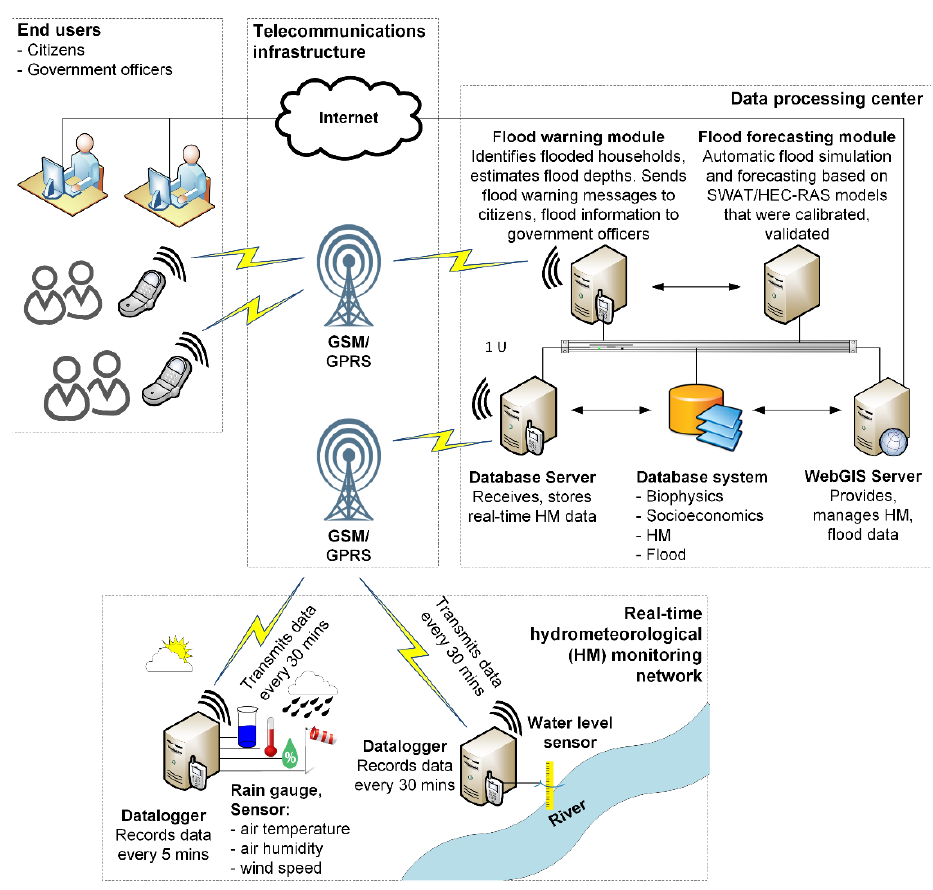
Figure 2. Flood warning system in the Vu Gia-Thu Bon river basin.